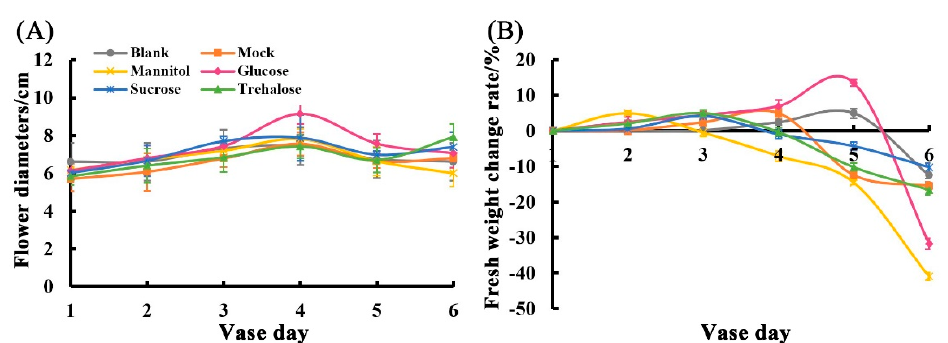
Figure 7. The appearance of flowering morphological changes of cut P. lactiflora in a fresh-keeping solution containing different carbon sources.